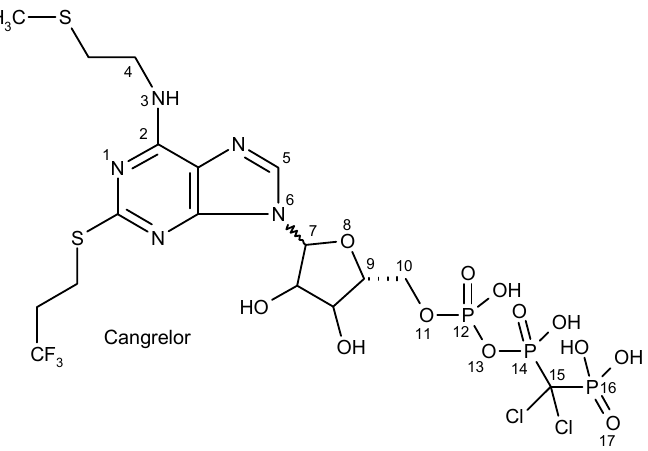
Figure 1. Structure and atom labeling in the antiplatelet drugs investigated.